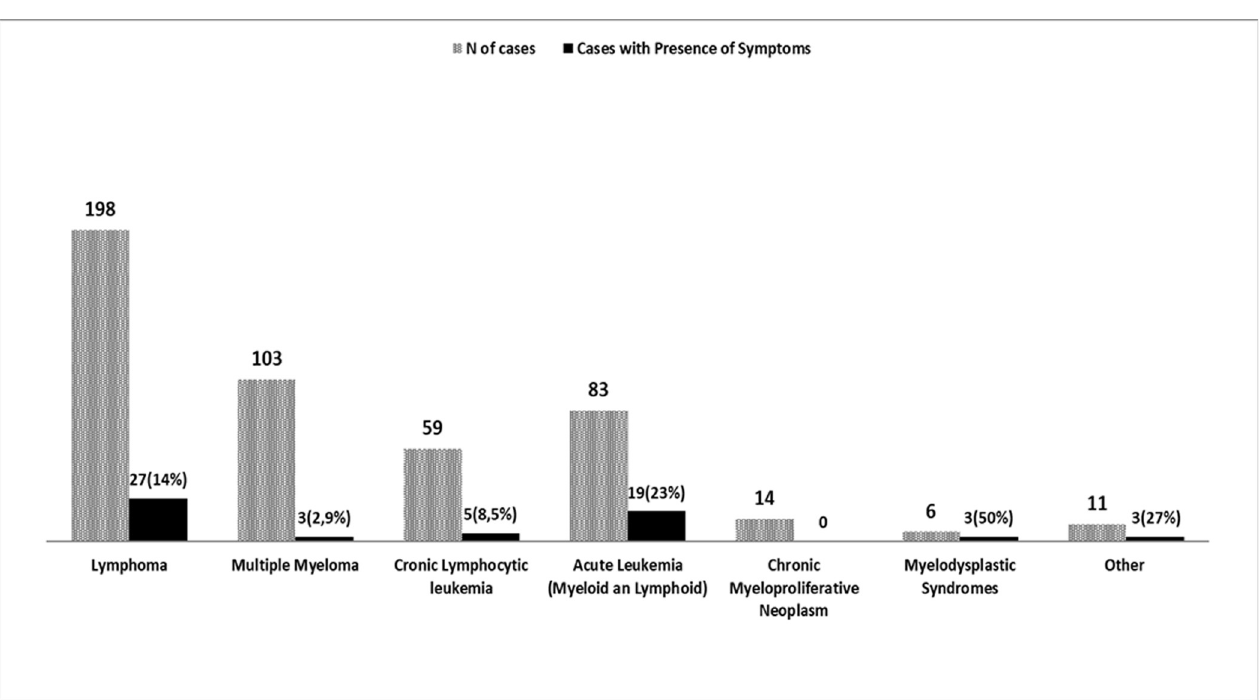
Fig 2. Number of cases according to the hematologic cancer type and percentage of patients who declared one or more symptoms potentially COVID- 19-related at the specific triage procedure.